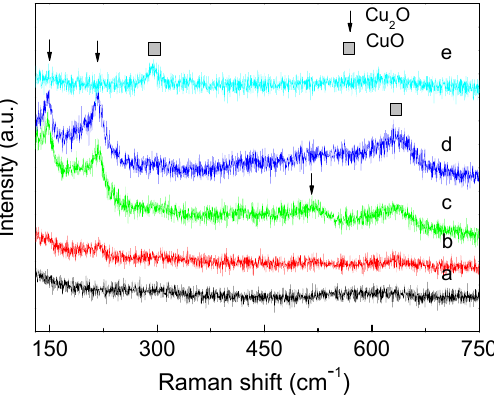
Figure 5. Raman spectra of Cu 3 P films annealed at different temperatures: ( a ) 50 °C; ( b ) 100 °C; ( c ) 200 °C; ( d ) 300 °C and ( e ) 400 °C, respectively.